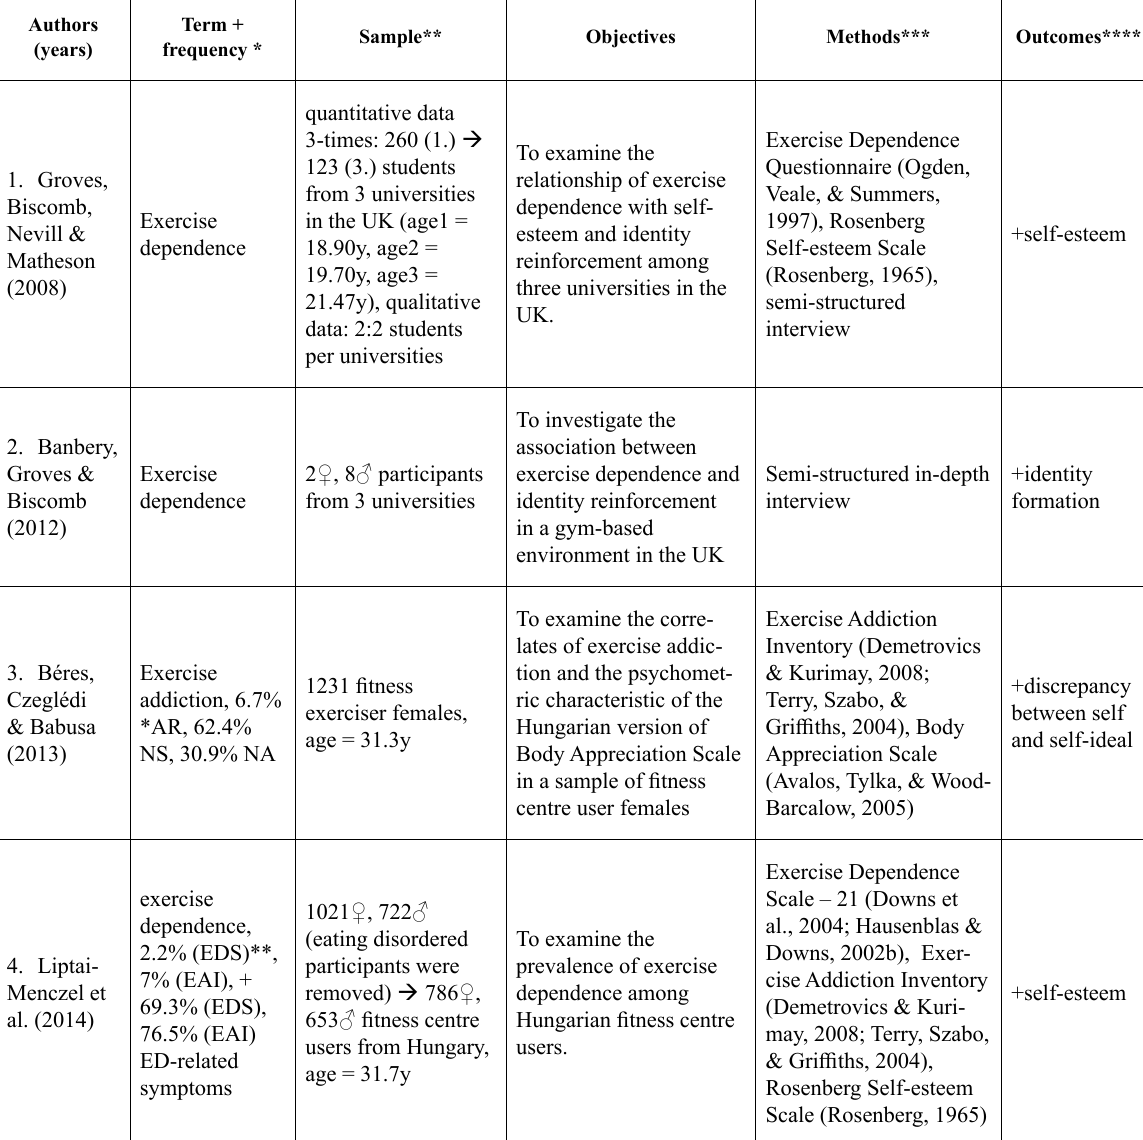
Table 5. Summary of studies between 1995 and 2016 investigating the relationship between exercise addiction and